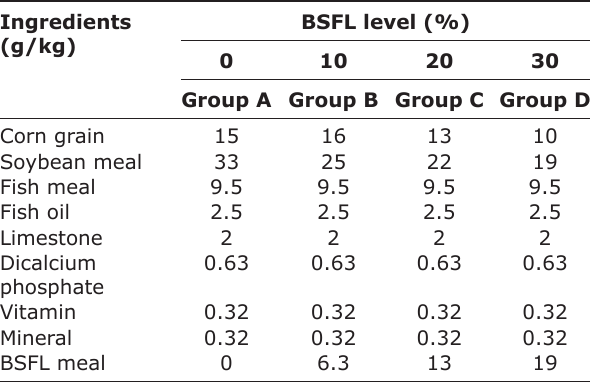
Table-1: Ingredients and composition (%, DM) of experimental diets formulation and BSFL. Ingredients